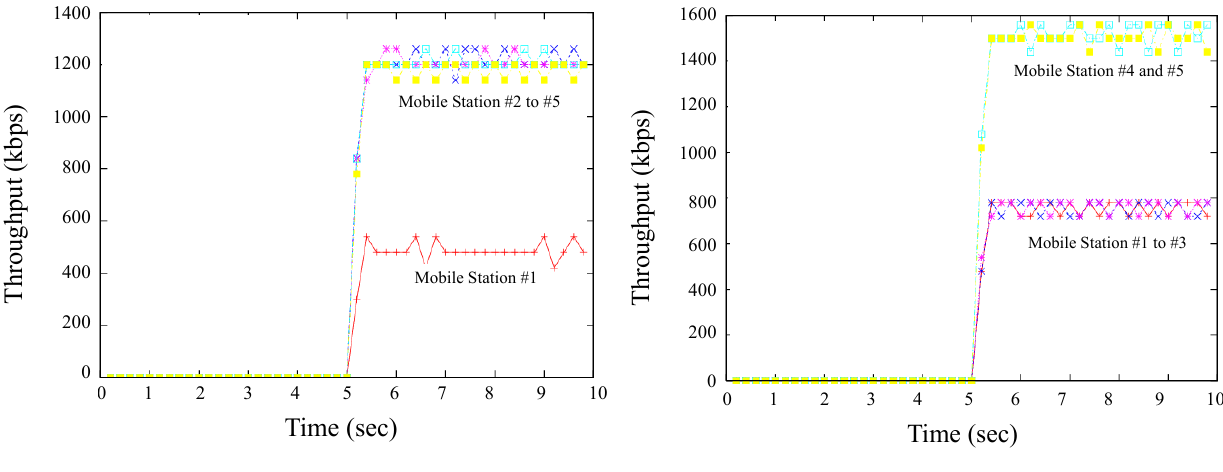
with 500 kbps r 1 to MS with traffic priority 1 3 5